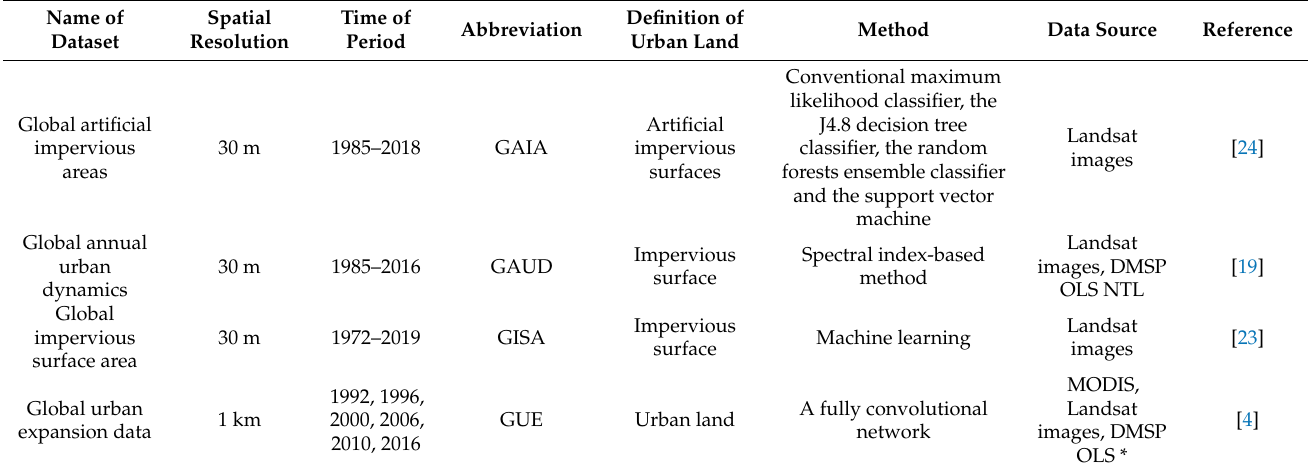
Table 1. Overview of the ISA datasets selected in the research.